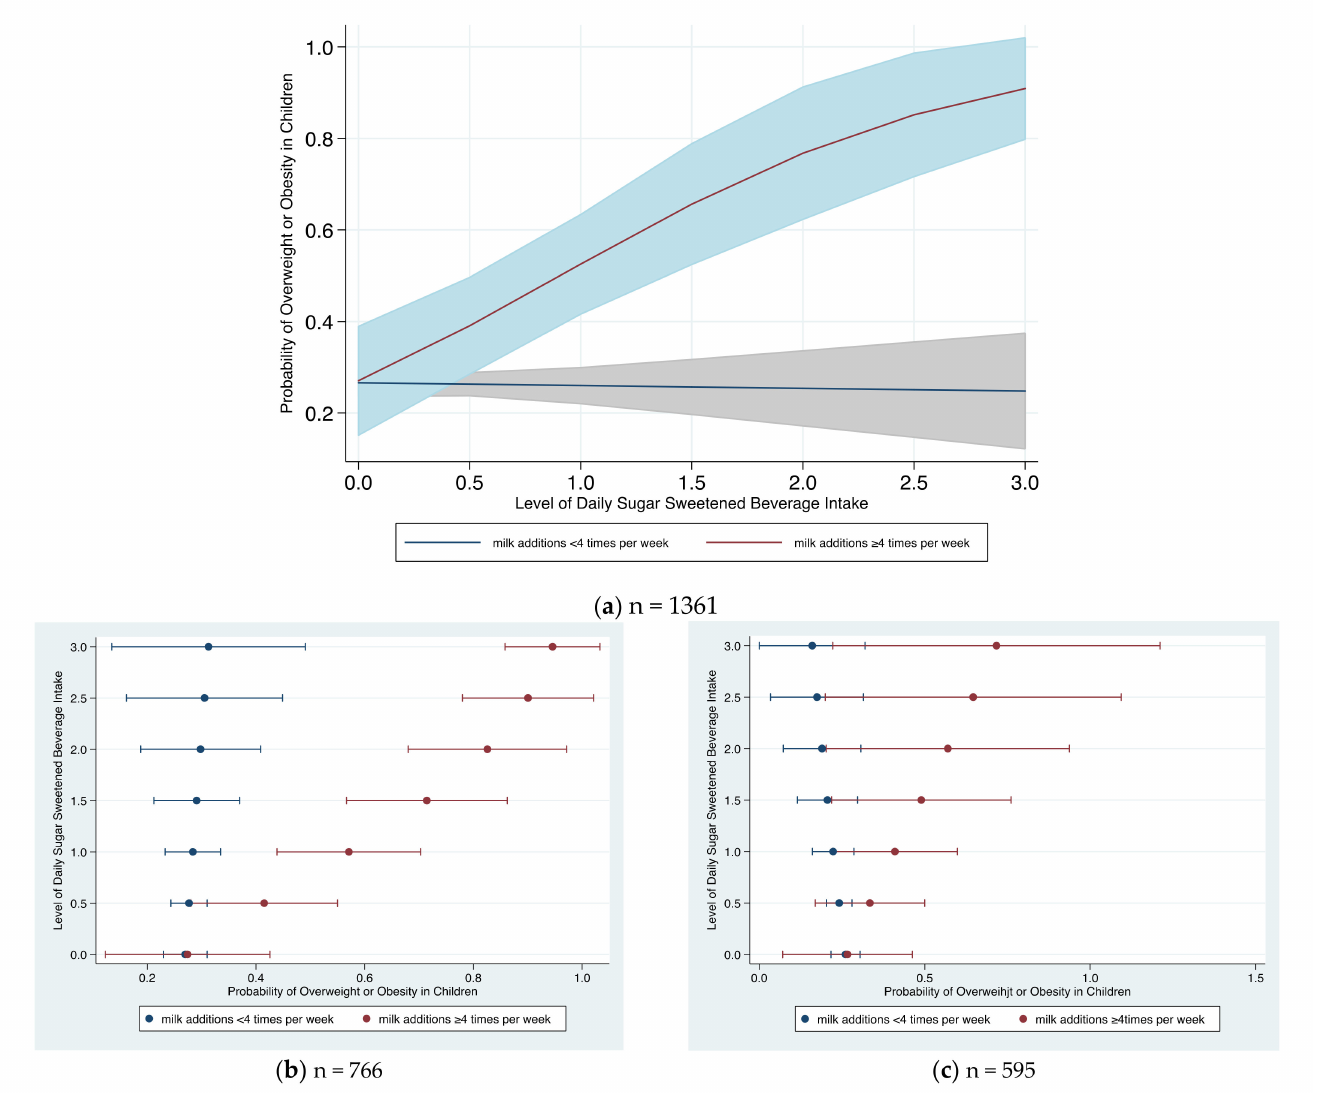
Figure 3. Predicted probability (mean and 95%CI) of children being overweight or obese with level of daily sugar-sweetened beverage intake by frequency of adding sugars to milk. ( a ) Predictive probability of SSB with frequency of milk additions on being overweight or obese adjusted for sex, age, intake of sweets, KIDMED score, being active ≥ 60 min, residence, and average sleep hours. Complete model for ( b ) children sleeping <10 h/day and ( c ) children sleeping >10